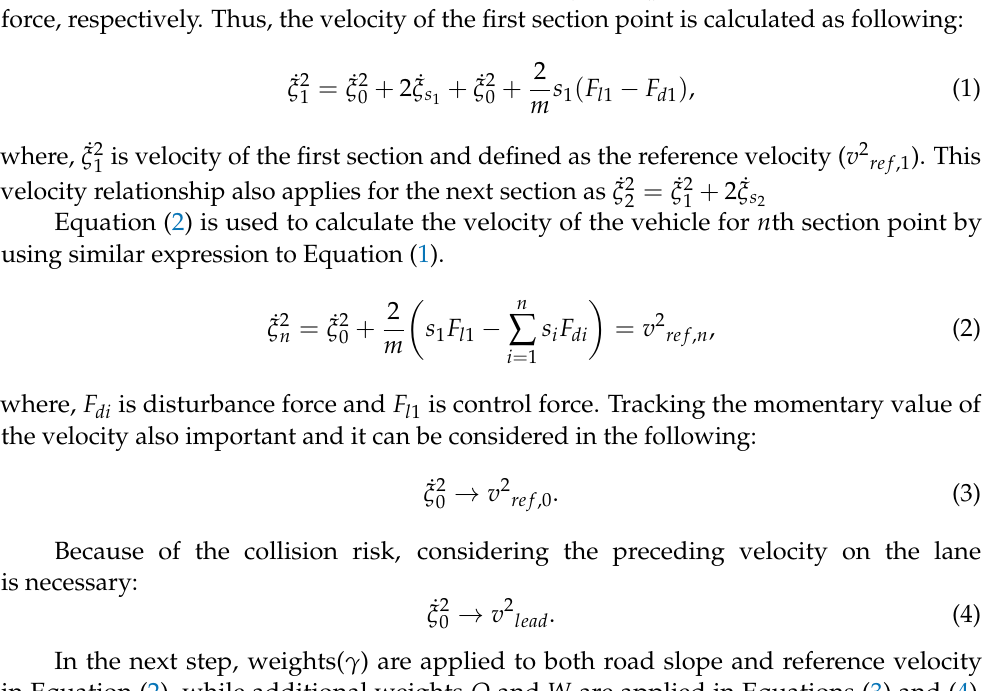
Figure 2. Forward road